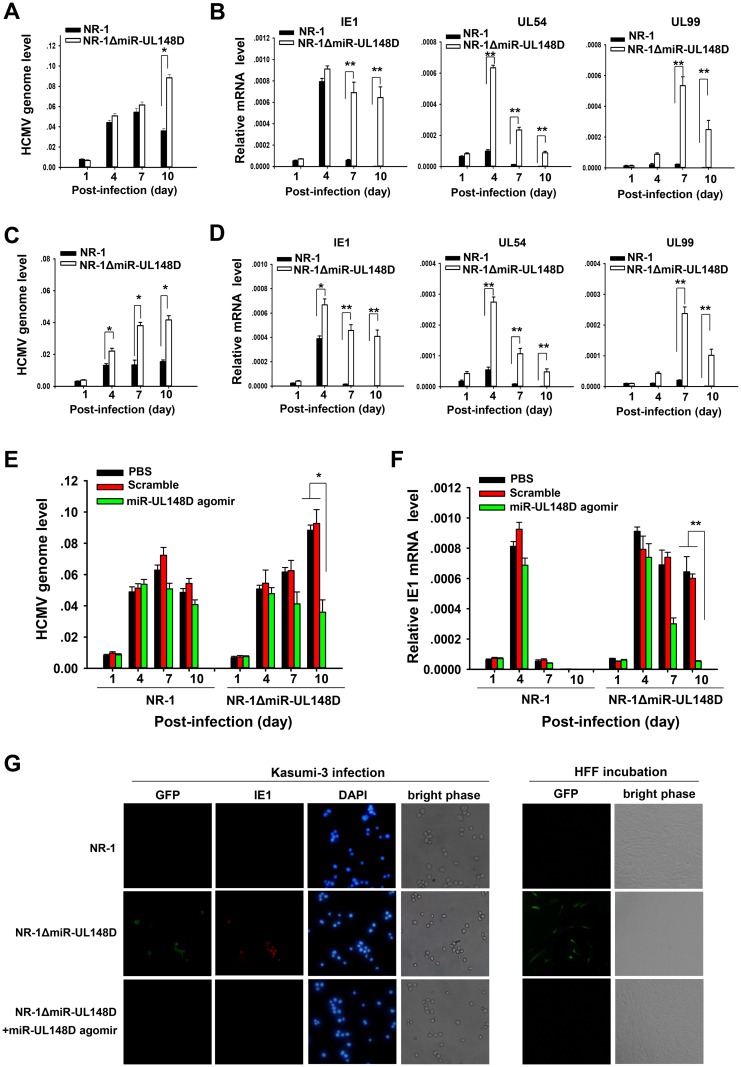
Knockout of miR-UL148D impairs the establishment of experimental NR-1 latency in Kasumi-3 cells.(A, C) HCMV genome copies in Kasumi-3 cells (A) and CD34+ HPCs (C) infected with NR-1 or NR-1ΔmiR-UL148D. Total DNA was isolated from the infected cells at various time points after infection, and viral DNA was quantified by qPCR and normalized to cellular GAPDH. (B, D) Representative transcript levels from each class of viral genes in Kasumi-3 cells (B) and HPCs (D) infected with NR-1 or NR-1ΔmiR-UL148D. IE1 (immediately early), UL54 (early lytic transcript), and UL99 (late lytic transcript). Total RNA was isolated from infected cells and assayed by RT-qPCR. Samples were assayed in triplicate, and GAPDH level was used for normalization. (E, F) Restoring miR-UL148D expression via transfection with the miR-UL148D agomir reduced HCMV genome copies (E) and IE1 (F) expression in NR-1ΔmiR-UL148D-infected Kasumi-3 cells. The miR-UL148D agomir was added 24 hours before viral infection, and the culture media was replaced everyday with the addition of fresh agomir. DNA and total RNA were isolated from the Kasumi-3 cells at various time points after infection and quantified by qPCR and RT-qPCR, respectively. Samples were assayed in triplicate, and GAPDH level was used for normalization. Results derived from NR-1-infected Kasumi-3 cells are shown as a control. (G) Both NR-1ΔmiR-UL148D- and NR-1-infected Kasumi-3 cells produced infectious progeny. Infected Kasumi-3 cells harvested 10 days post-infection were stained with a monoclonal antibody against IE1 (clone 1B12, shown in red). GFP (green) and DAPI (blue) served as markers for lytic infection and nuclei, respectively. Infected Kasumi-3 cells were also co-cultured with HFFs. Viral plaque formation in the HFFs (shown by a GFP-positive status) was visualized by fluorescence microscopy. Images were collected using a 40x objective, and representative fields are shown for each infection. Values are shown as the mean ± SEM (n = 3). *, P<0.05. **, P<0.01.